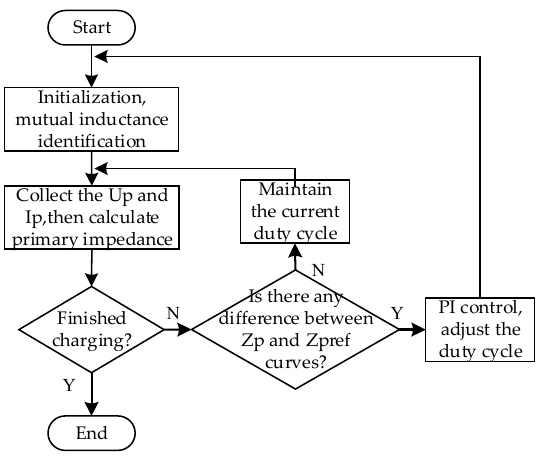
Figure 8. The flow chart of control.